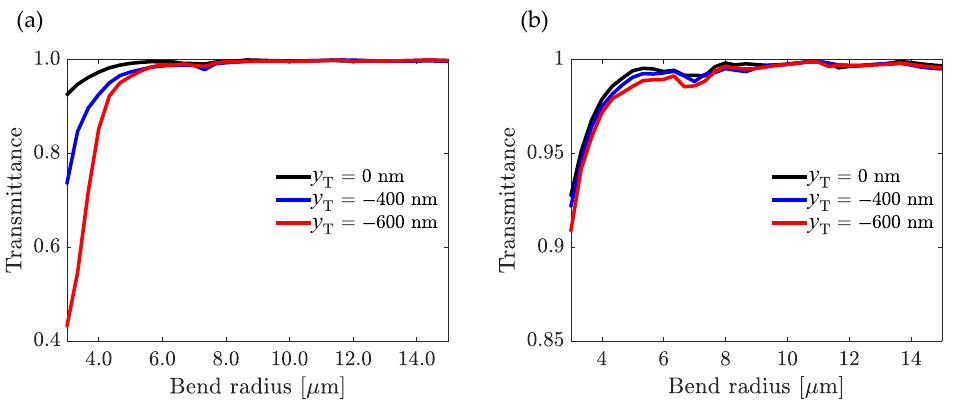
nm (black), nm (blue), Figure 7. TM 00 mode transmission after a U-turn bend for Figure 7. TM 00 mode transmission after a U-turn bend for y T = 0 nm (black), y T = − 400 nm (blue), and nm (red) for: ( a ) when is varied in the entire U-turn bend waveguide and ( b ) and y T = − 600 nm (red) for: ( a ) when y T is varied in the entire U-turn bend waveguide and ( b ) when 𝑦𝑦 T = 0 𝑦𝑦 T = − 400 when is varied only at the bend section. y T = 0 is varied only at the bend 𝑦𝑦 T = − 600 𝑦𝑦 T 𝑦𝑦 T = 0